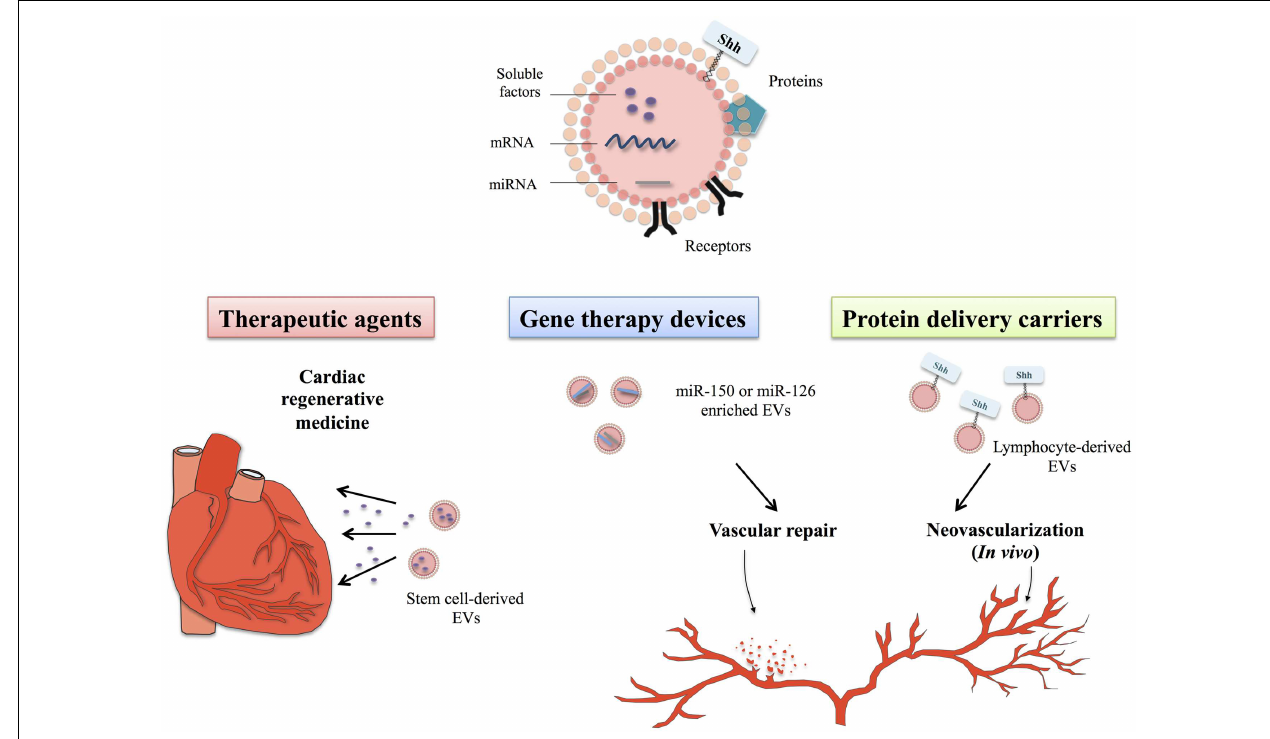
material, cell sources can be genetically manipulated to produce EVs specifically loaded with miRNA of choice, such as miR-150 or miR-126, described as important regulators of angiogenesis or vascular integrity. Treatment of endothelial cells or vascular tissues with these miRNA-enriched EVs has demonstrated their protective and regenerative properties on cardiovascular system. Specific culture system might also allow to specifically targeting molecules of interest to EVs, like the morphogen Shh that is an important regulator of injury-induced angiogenesis and neovascularization. Use of EVs Shh + even appears in this context more powerful than classical recombinant Shh protein, likely linked to its localization within natural EV membranous